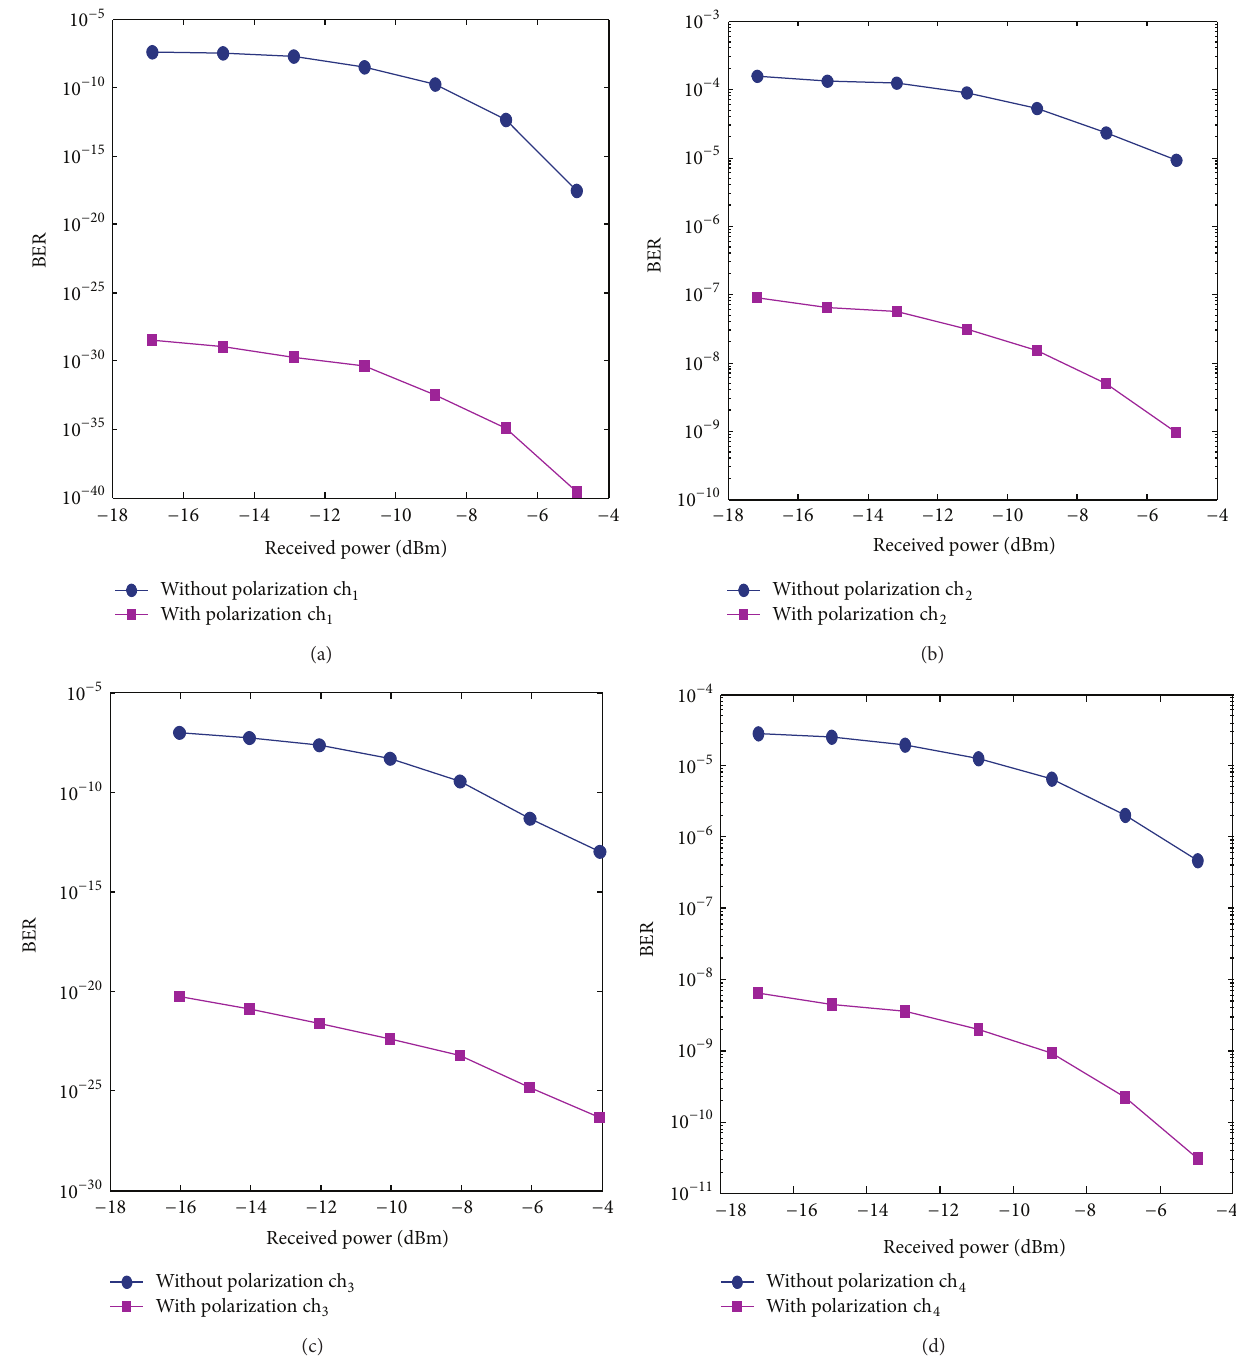
Figure 3: Received power versus BER in the presence and absence of the polarization techniques at (a) ch 1 , (b) ch 2 , (c) ch 3 , and (d) ch 4 .